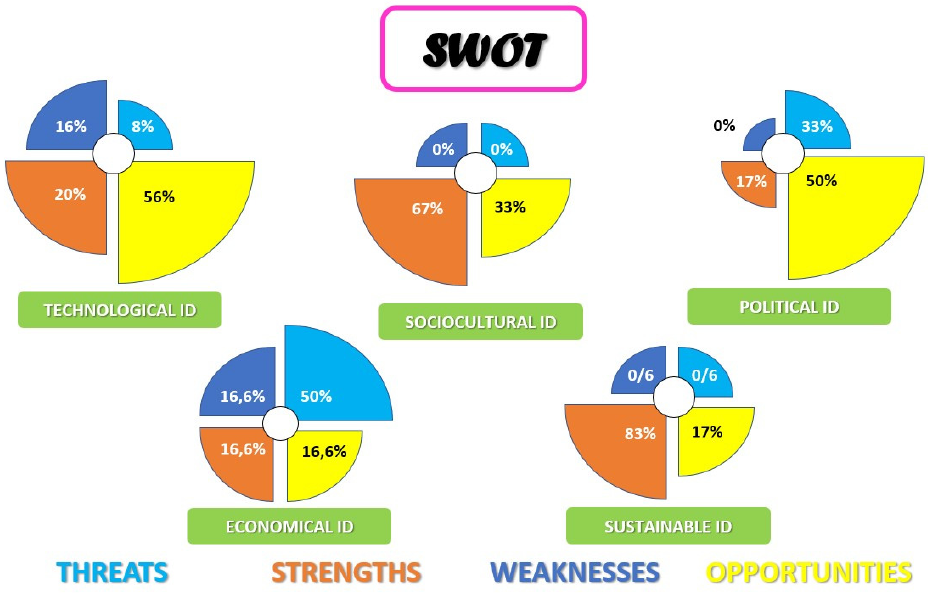
Figure 12. SWOT macro-environment by ID percentages. Source: own elaboration.